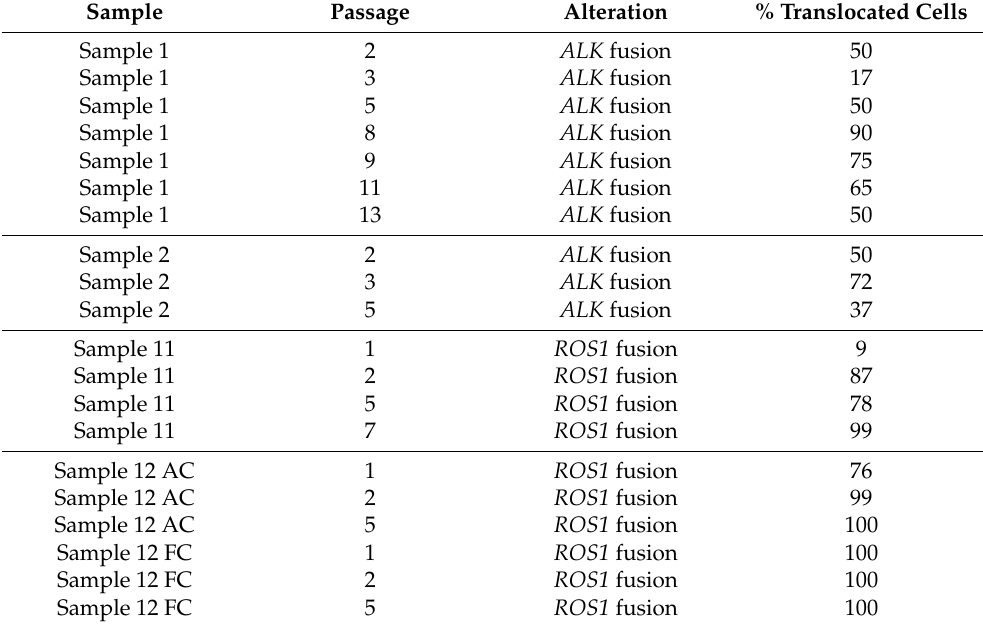
Table 2. Results of detection of ALK and ROS1 fusions by FISH in primary cultures. AC, adherent cells; FC, floating cells.